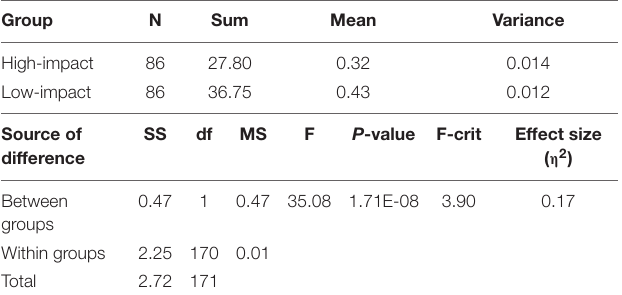
TABLE 7 | Variance analysis of differences between high-impact and low-impact